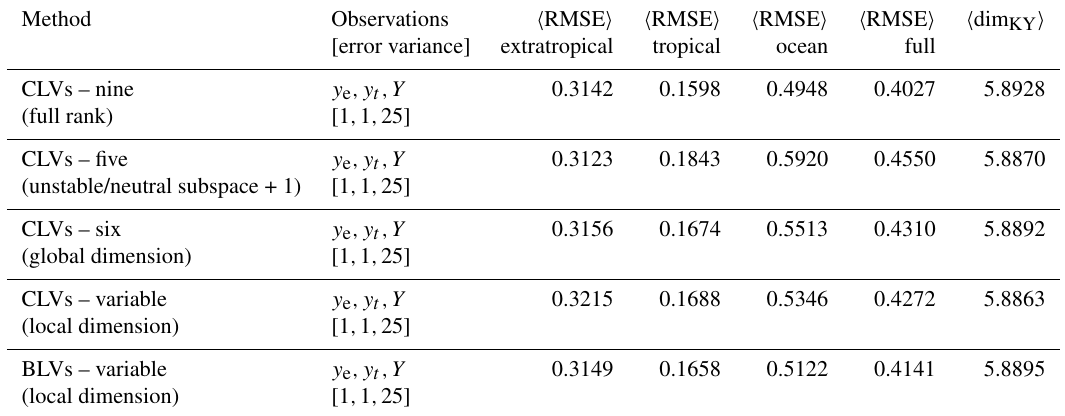
Table 2. Summary metrics of DA experiments using a right-transform matrix (Eq. 15) and benchmark observations ( y e ,y t ,Y ). The angle brackets (cid:104)·(cid:105) denote the average over assimilation steps. Compare to results in Yoshida and Kalnay (2018). Parameters: assimilation window 0.08, inflation factor 1%, 10 ensemble members.